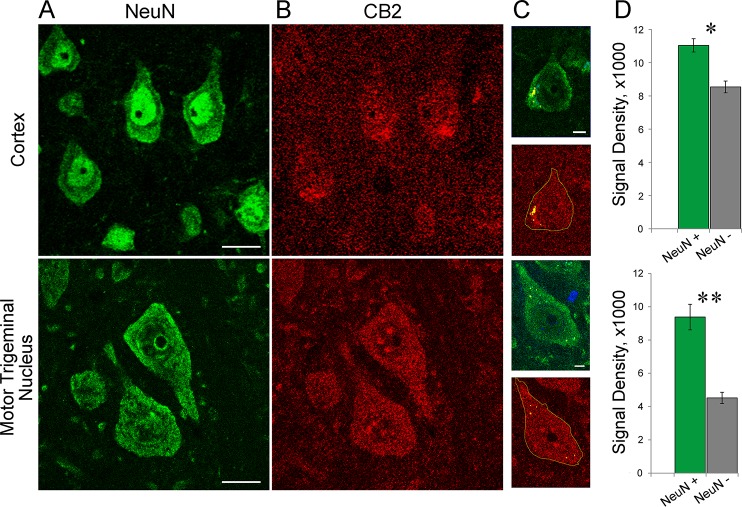
CB2 immunoreactivity in neurons of the cortex and motor trigeminal nucleus of 12 mo-old APPswe/PS1ΔE9 transgenic mice.Representative confocal images of cortical neurons (upper panels) and neurons of the motor trigeminal nucleus (lower panels) with double immunostaining using NeuN (green; A) and CB2 R (red, H60: B) primary antibodies. Scale is 15 μm. C. Example of neuronal bodies visualized by NeuN (green). The neuron outlines were transferred to CB2 channel (red). Note cytoplasmic granules (pseudo-yellow) with autofluorescence visible on DAPI channel (not shown). The areas occupied by such granules were not considered in the analyses of CB2 immunoreactivity. Scale is 5 μm. D. Quantification of CB2 densities (integrated intensities/area) in NeuN-positive and –negative areas. Signal intensities were averaged across 30 non-overlapping fields (n = 2 mice). * and ** indicate significant differences in CB2 signal between NeuN-positive areas and background, p<0.01 and 0.001, respectively (ANOVA).